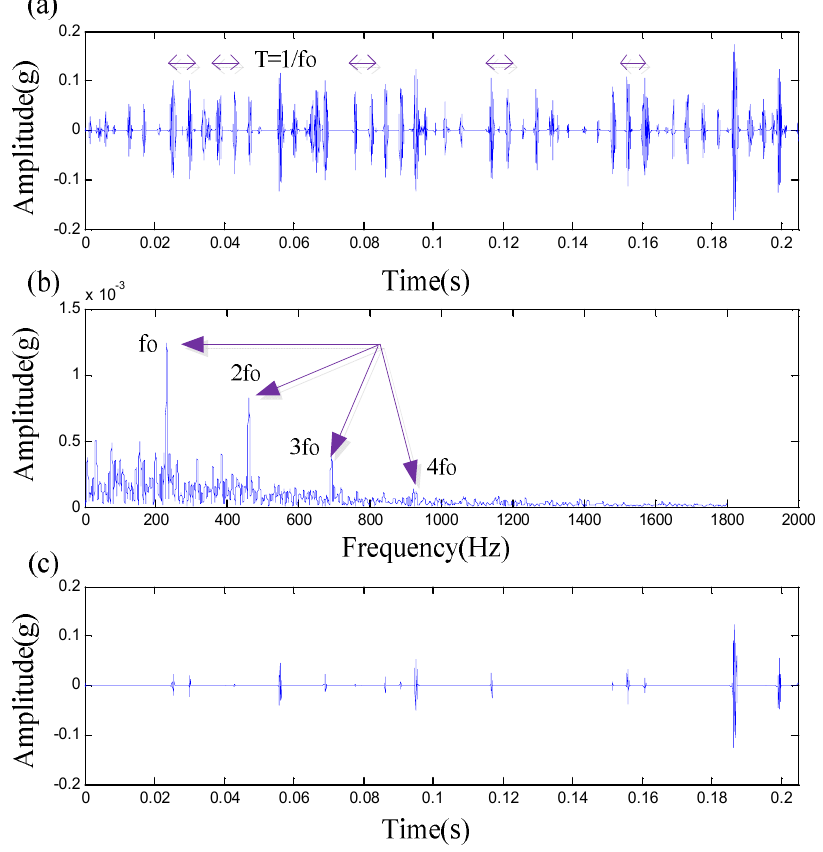
Figure 7. ( a ) De-noising signal by NSD ( b ) Envelope spectrum of the de-noising signal ( c ) De-noising signal by Donoho threshold.